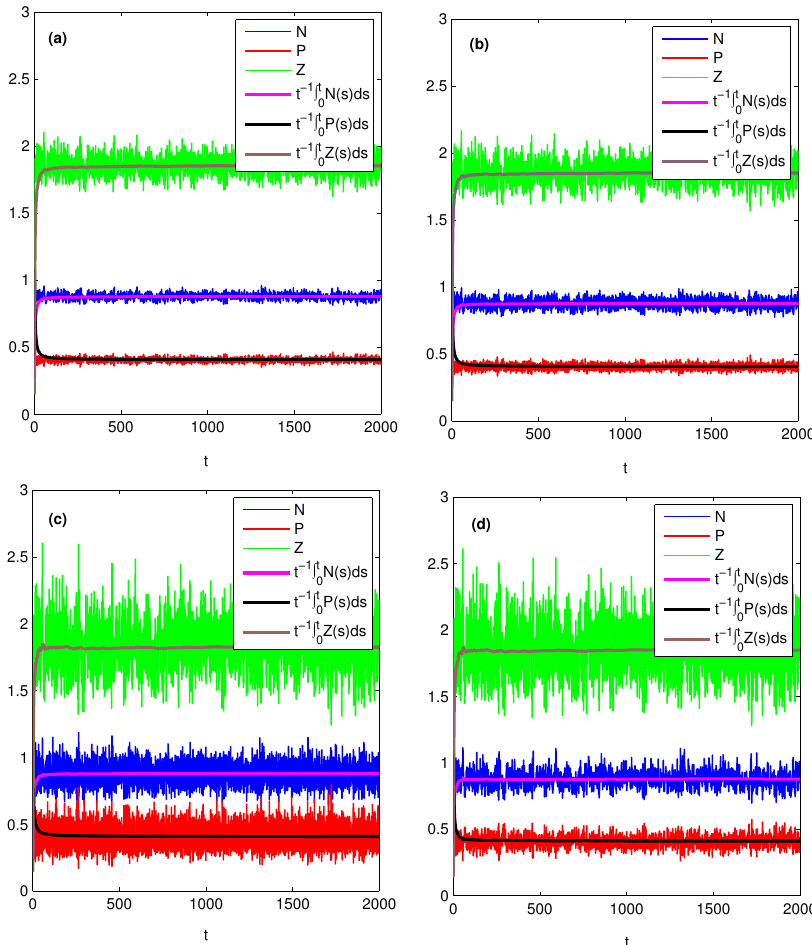
Figure 2. Effects of noise on the population persistent level. Here, a = 4, c = 1.6, D = 1, D 1 = 0.25, D 2 = 0.25, µ 1 = 0.3, µ 2 = 0.4, µ 3 = 0.08, µ 4 = 0.15, N 0 = 2. Then R 1 = 9.7545 > 1, and E ∗ = ( 0.8804,0.4063,1.8573 ) which is asymptotically stable. ( a ) σ 1 = 0.02, σ 2 =